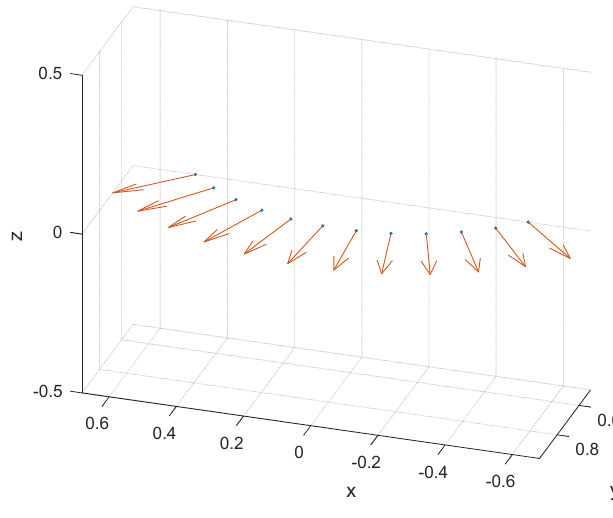
Figure 2. Geometry of conformal